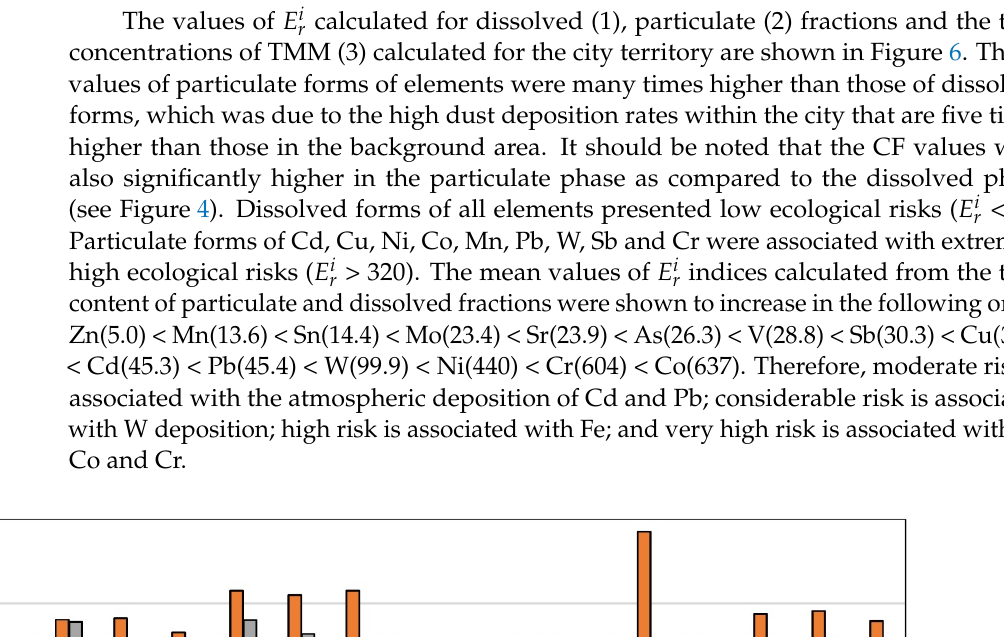
Figure 7. RI distribution in Tyumen City: ( a ) the frequency distribution of RI total values in snow samples and ( b ) mean values of RI within different land-use areas, based on the total content of particulate and dissolved ТММ s in the snowpack. Land-use areas: 1—the historical center; 2—low-rise residential area; 3—high-rise residential area; 4—modern business zones; 5—industrial zones; 6—transport zones.